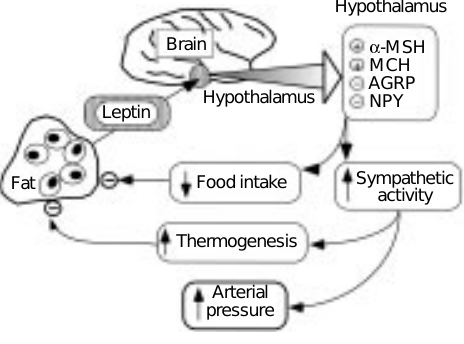
Figure 6 - Possible links be- tween leptin and its effects on the hypothalamus, sympathetic activation, and hypertension. a - MSH, Melanocyte stimulating hormone; MCH, melanin-con- centrating hormone; AGRP, agouti-related peptide; NPY,